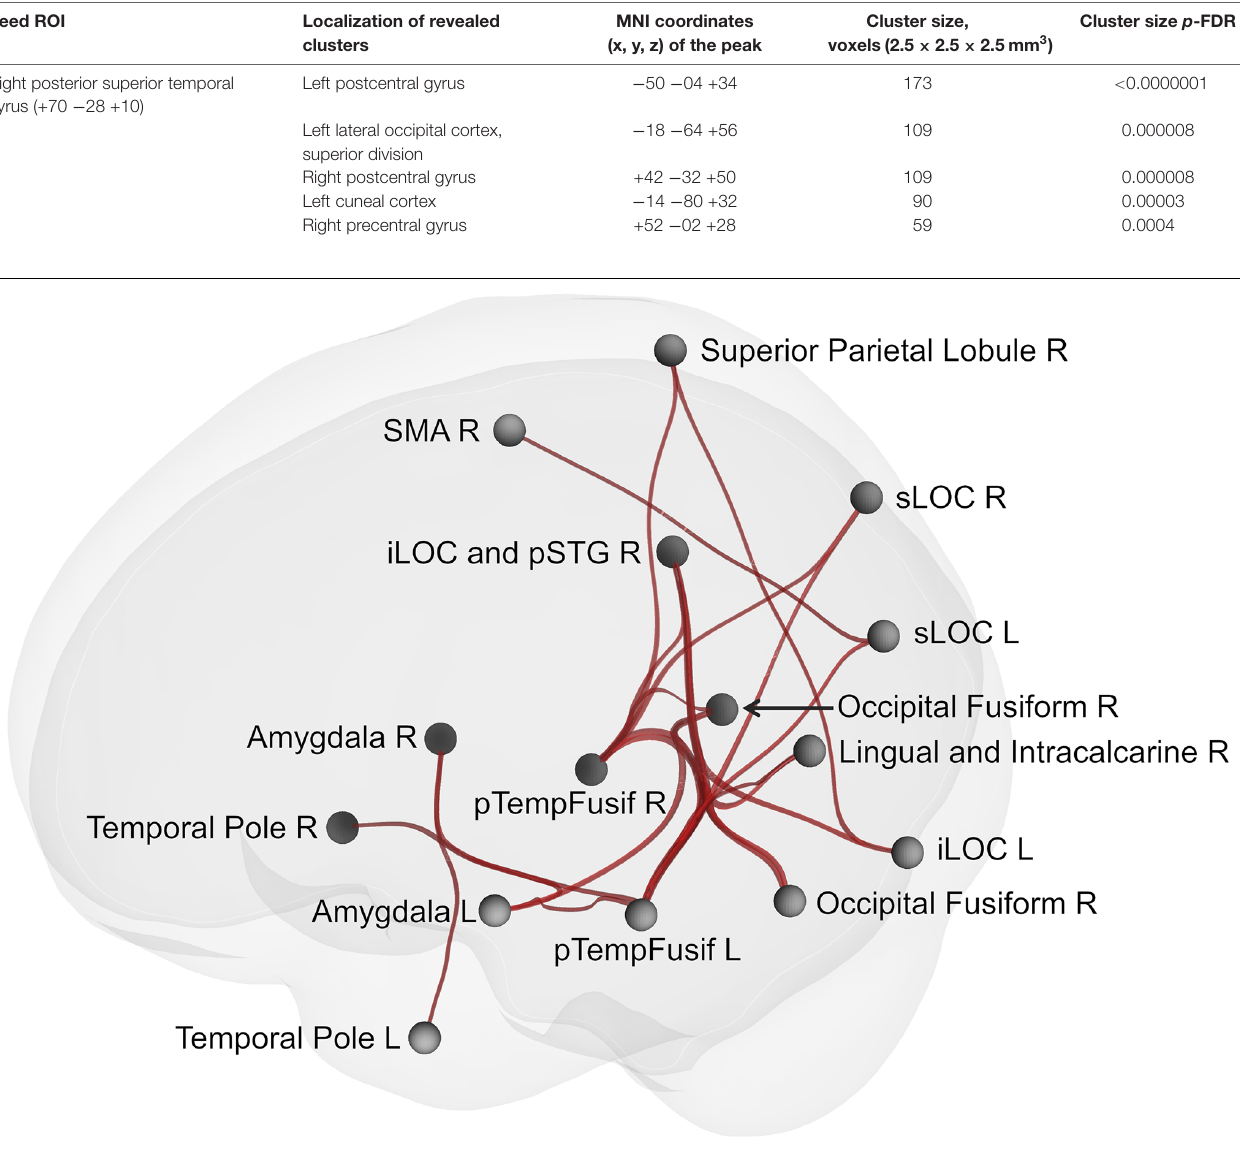
TABLE 3 | Clusters showing increased connectivity with the seed regions after the control trainings.